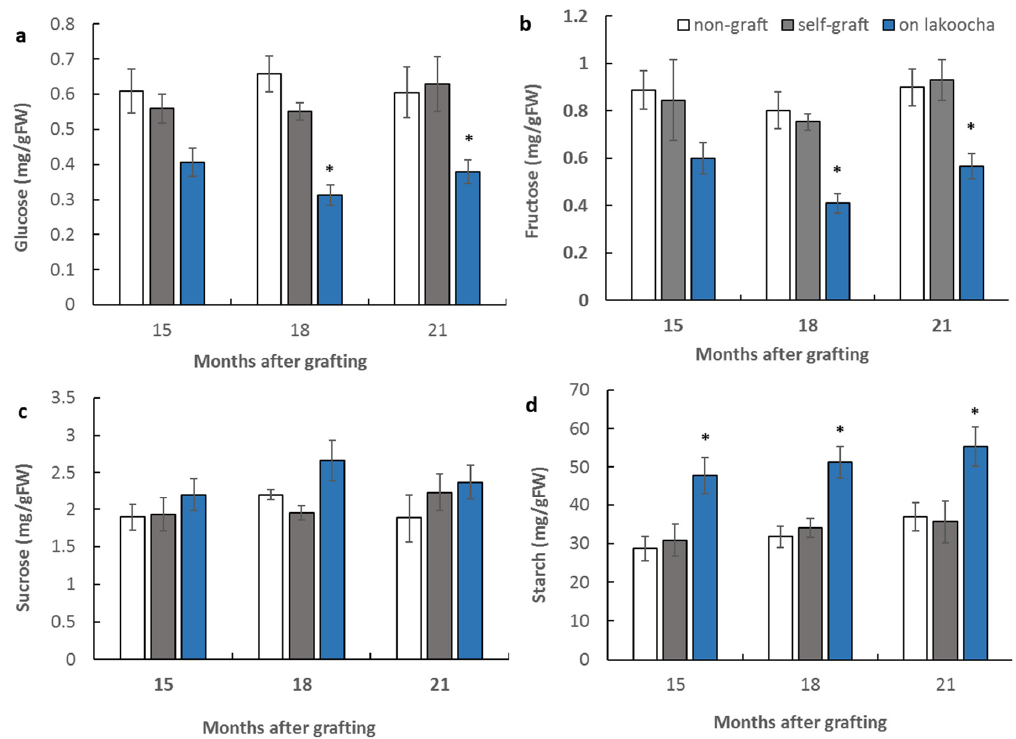
Figure 5. Non-structural carbohydrate contents in root tissues of different rootstocks. (a) Glucose contents; (b) Fructose contents; (c) Sucrose contents; (d) Starch contents. All values represent mean ± SE from five biological replicates (* p < 0.05).